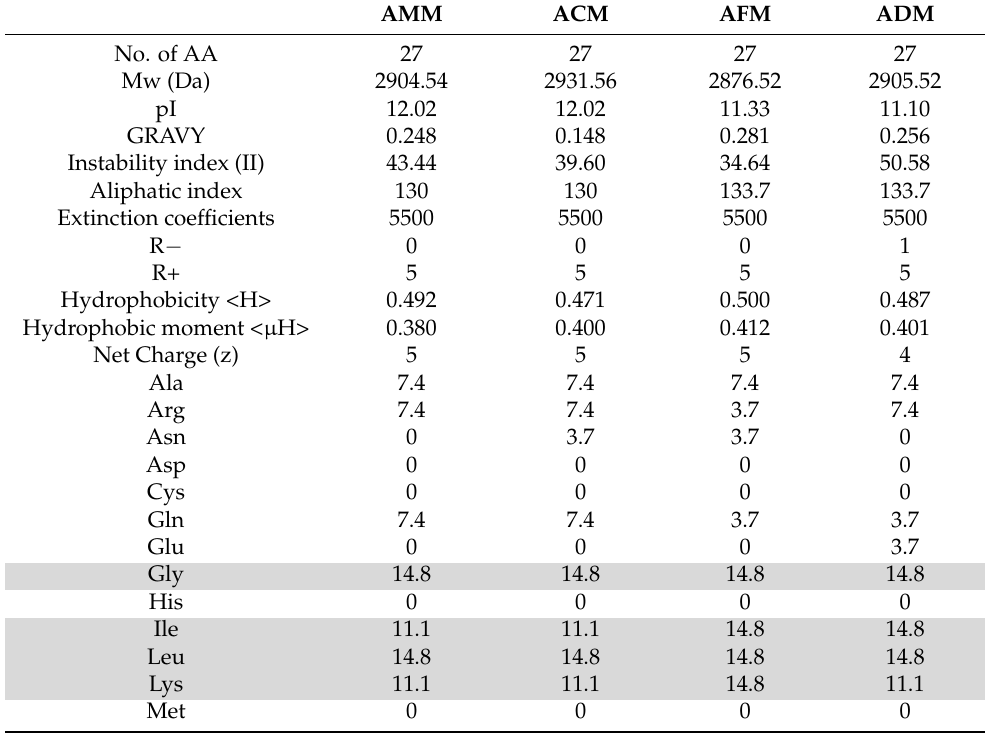
Table 2. Amino acid composition (%) and physicochemical parameters of melittin from four honey bee species computed by ExPAsy ProtParam and HeliQuest. Shading indicates the four most abundant amino acids in each melittin.